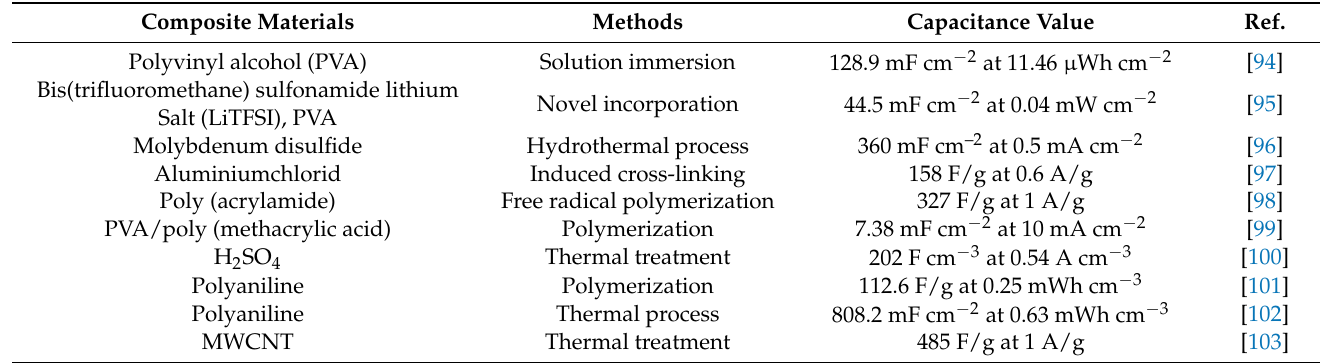
Table 3. Comparison of supercapactive performance of PEDOT: PSS-based